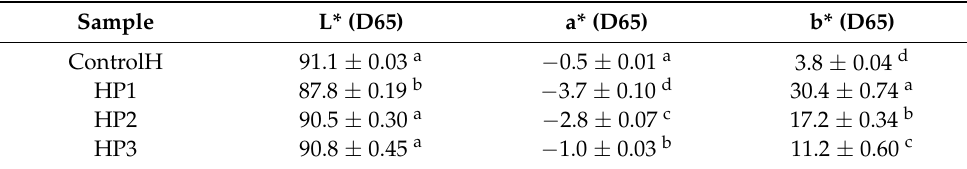
Table 2. Color parameters of the films.